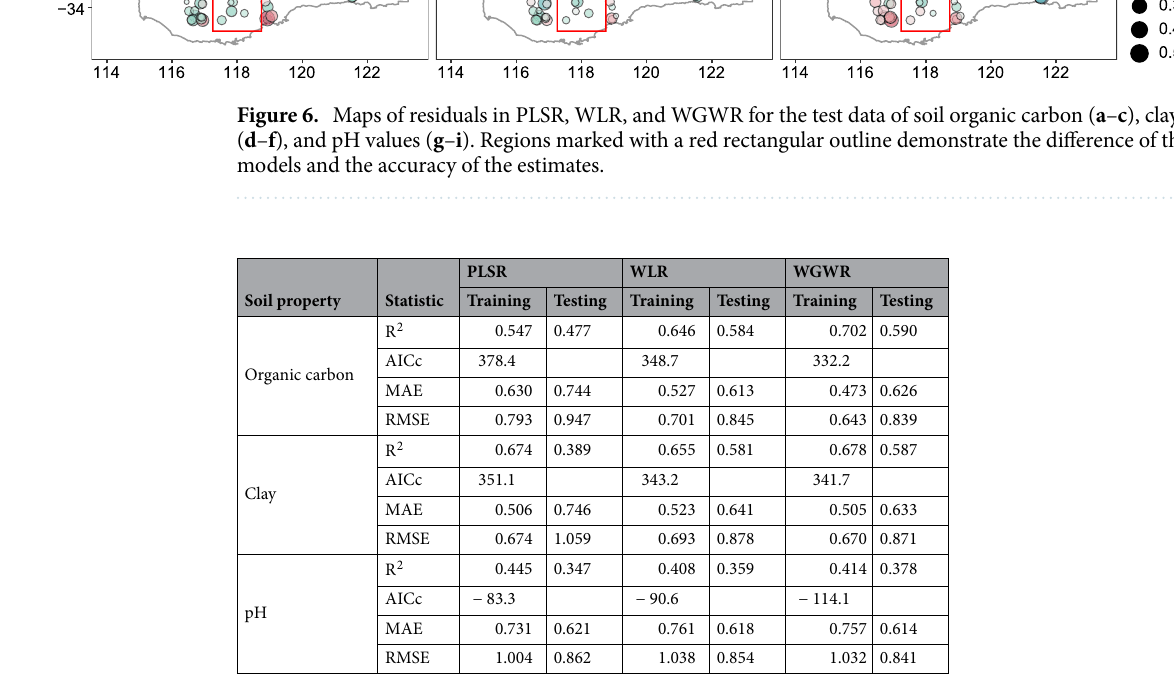
Table 2. Assessment statistics for the validation of PLSR, WLR and